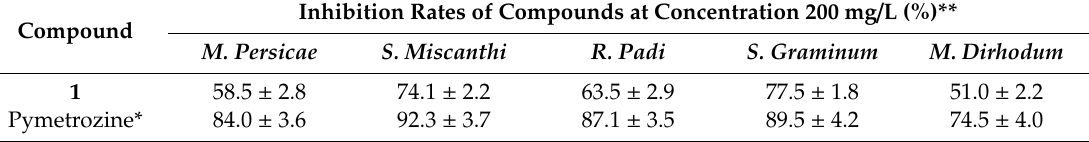
Table 4. The in vivo aphicidal activity of Compound 1 .